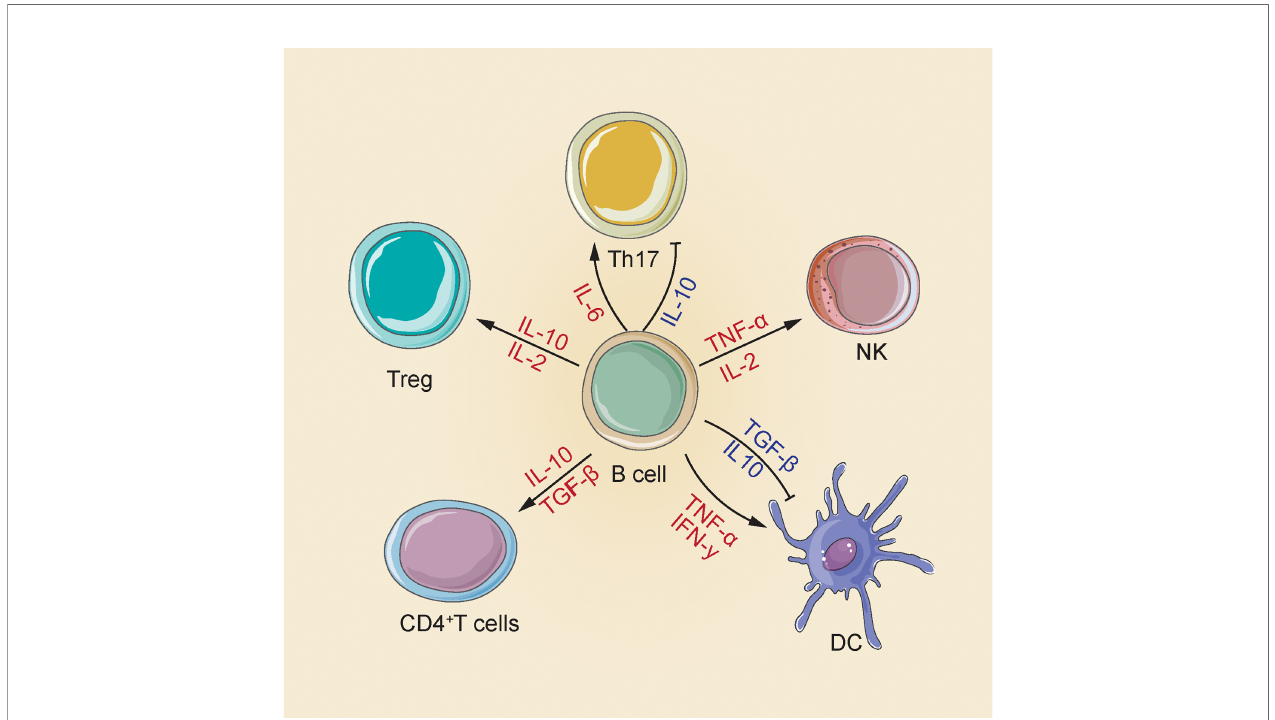
FIGURE 1 | There are multiple mechanisms for the positive and negative effects of B cells produced by cytokines in the immune response. B cells increase NK cell activation and Treg differentiation by releasing IL-2 and TNF- a ; releasing of IL-2 and IL-10 to enhance Treg differentiation; releasing of IL-10 and TGF- b CD4 + T cell apoptosis and inhibit DC maturation, and also secrete IFN- g and TNF- a to induce DC maturation; release IL-10 to inhibit Th17, release IL-6 to enhance Th17 response